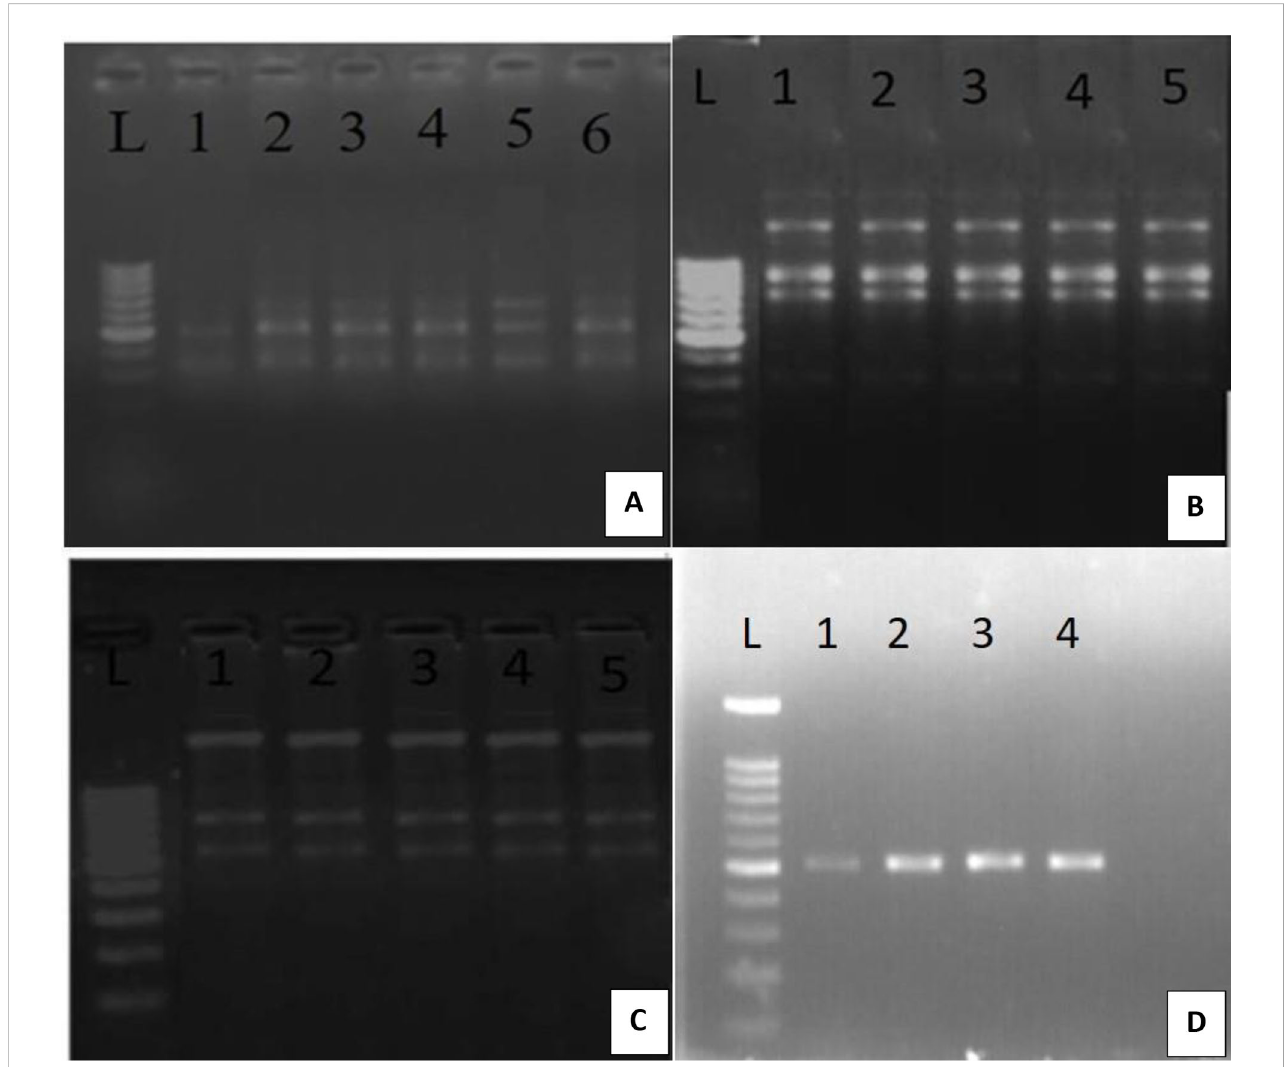
FIGURE 3 Genetic fi delity analysis of in-vitro and mother plants of D transparens using RAPD marker (A) OPA 10 Primer L- Lader, 1 to 5 in-vitro plants; 6 mother plant; (B) OPA03 Primer L- Lader, 1 to 4 in-vitro plants; 5 mother plant. (C) OPA06 Primer L- Lader, 1 to 4 in-vitro plants, 5 mother plant, (D) OPA07 Primer L- Lader, 1 to 3 in-vitro plants 4 mother plant; (Size of ladder- 1000